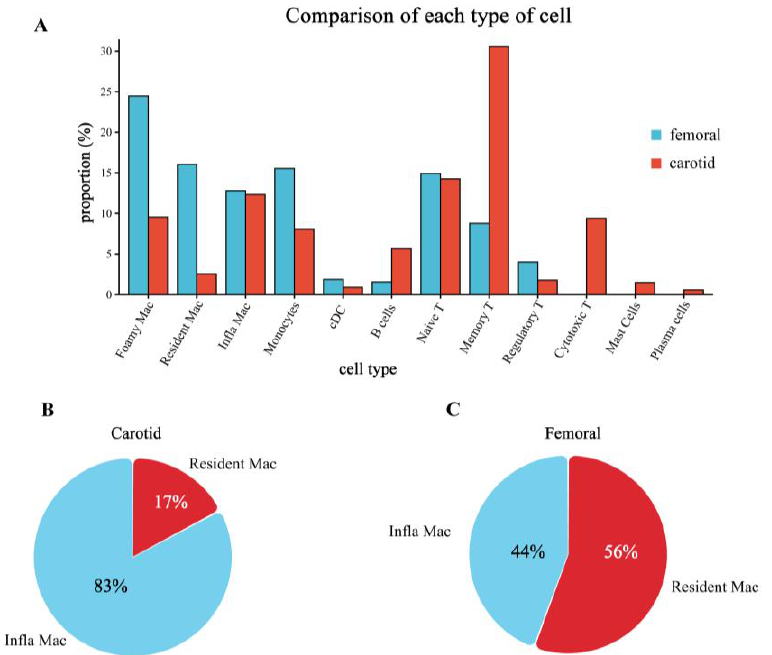
Figure 4. Comparison of immune cells between carotid and femoral plaques. ( A ). Cell percentage changes of each cluster in carotid and femoral samples are shown. The red bar represents carotid arteries. The blue bar represents femoral arteries. ( B ) The pie chart shows the proportions of resident macrophages and inflammatory macrophages in the carotid. ( C ) The pie chart shows the proportions of resident macrophages and inflammatory macrophages in femoral samples. Blue represents inflammatory macrophages. Red represents resident macrophages.